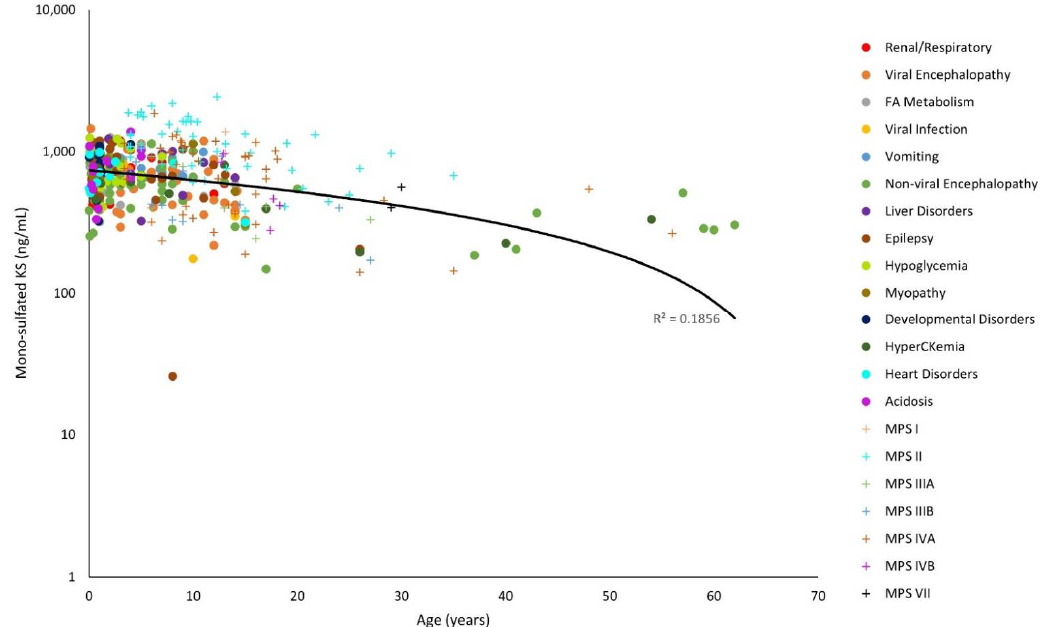
Figure 4. Mono-sulfated keratan sulfate (KS) levels with age on a logarithmic scale. The linear trendline of control values is shown as a black line, and glycosaminoglycan (GAG) values of patients with mucopolysaccharidosis (MPS) are shown as plus marks.